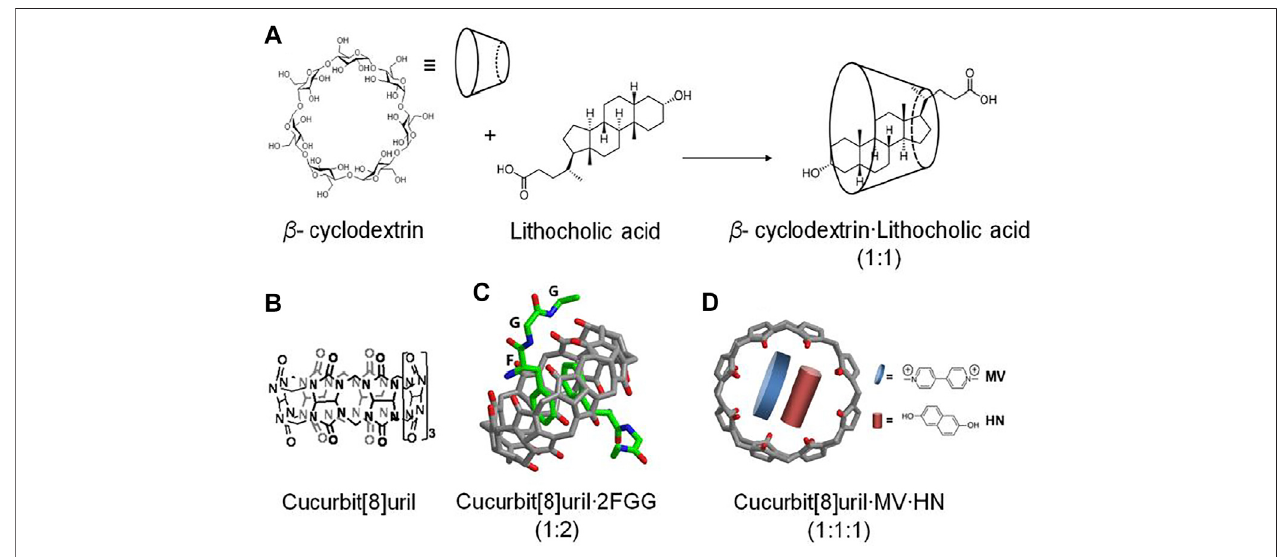
FIGURE5|(A) β -cyclodextrinrecognizesandbindslithocholicacidformingacomplex(1:1)(YangandBreslow,1997), (B) Chemicalstructureofcucurbit[8]uril, (C) cucurbit[8]uril selectively binds and dimerizes tripeptide phenylalanineglycine · glycine (FGG) (Heitmann et al., 2006), (D) ternary complex of cucurbit[8]